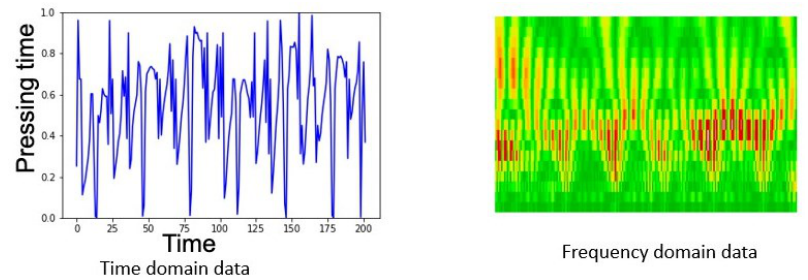
Figure 9. Examples of time and frequency domain data in the dataset.